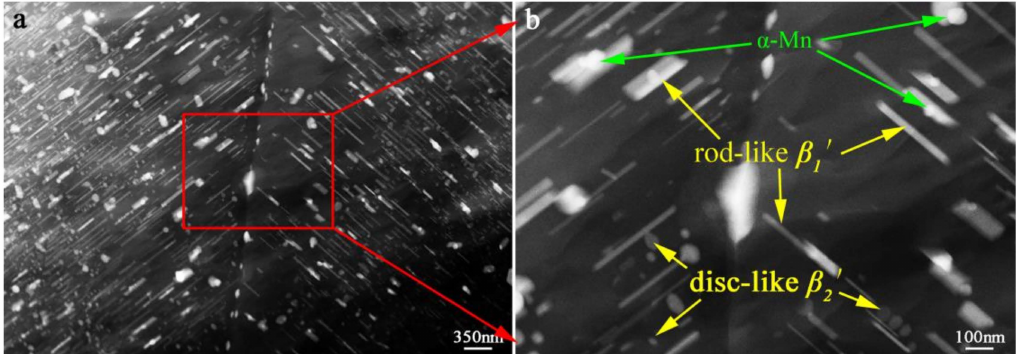
Figure 12. ( a ) HADDF-STEM image of the double-aged ZM51 alloy, ( b ) the enlargement of the rectangular part in the circle in ( a